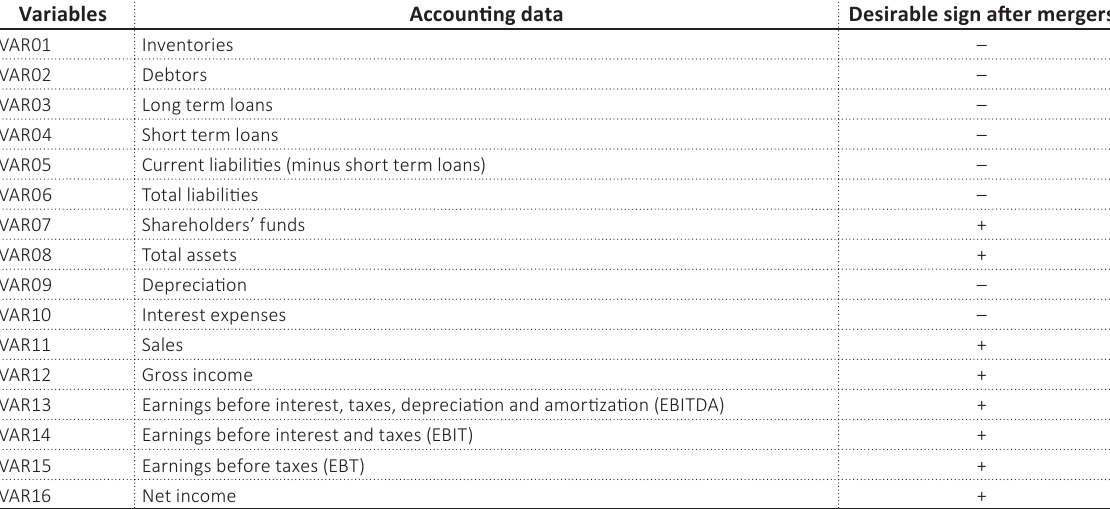
Table 1. Accounting